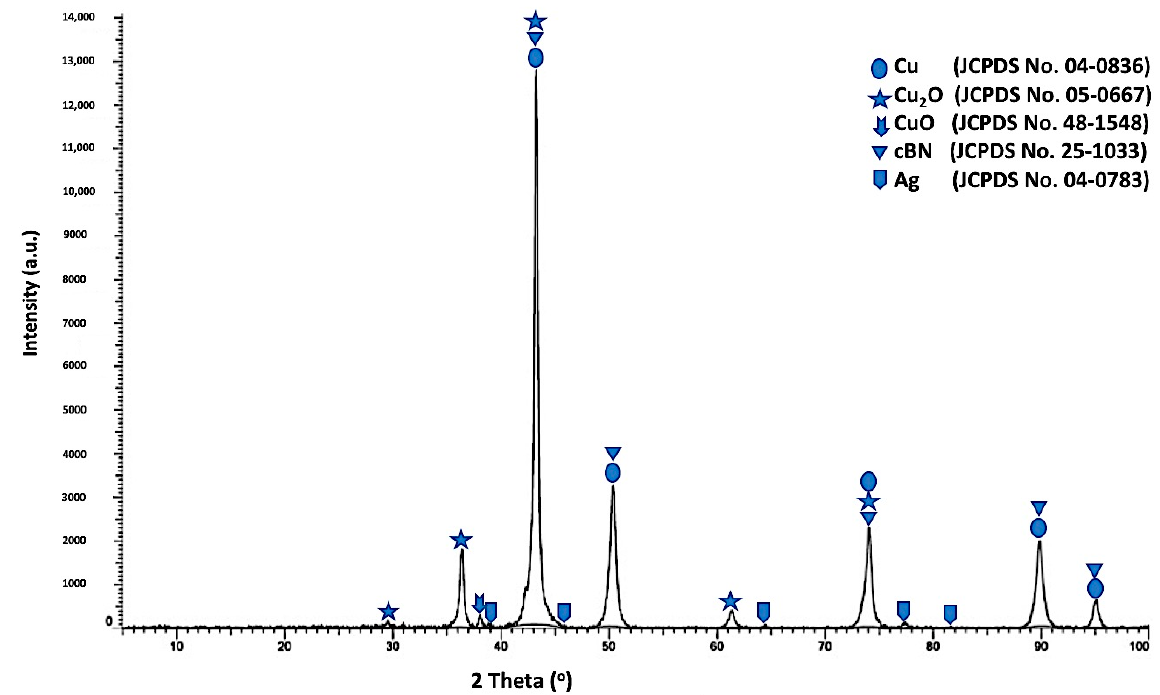
Figure 12. X-ray diffraction pattern of Tin/Silver-metallized cBN/Cu composite particles. Figure 12. X ‐ ray diffraction pattern of Tin/Silver ‐ metallized cBN/Cu composite particles. It was also observed from the study of the morphology of the deposited copper layers on the metallized cBN particles by the two different methods that the tin/silver-metallized cBN particles were mostly encapsulated by a condensed copper layer. However, the